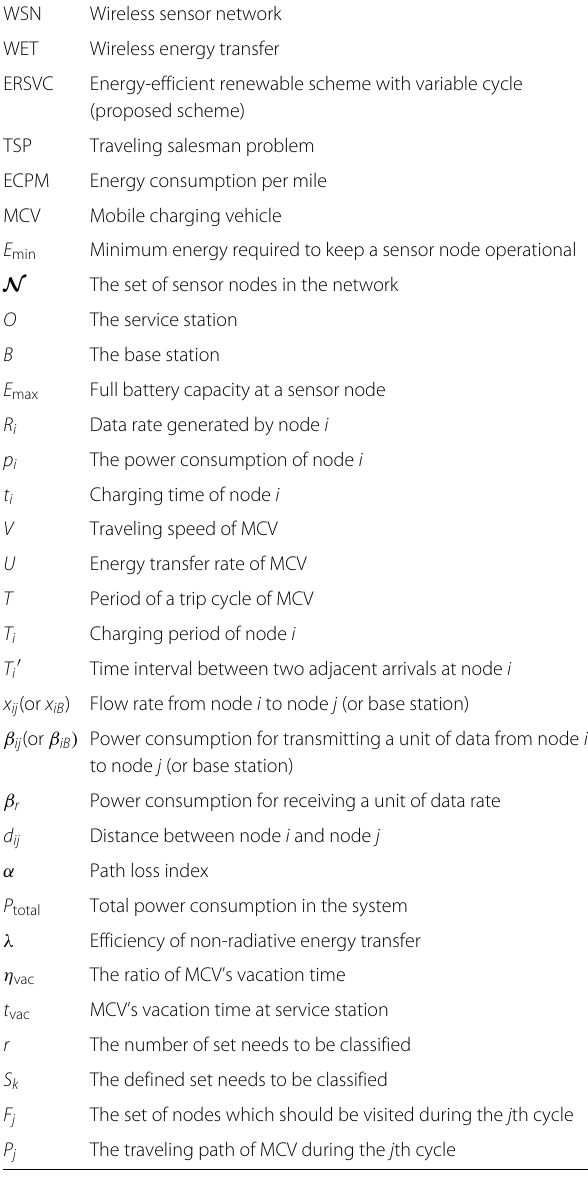
Table 1 Abbreviations and